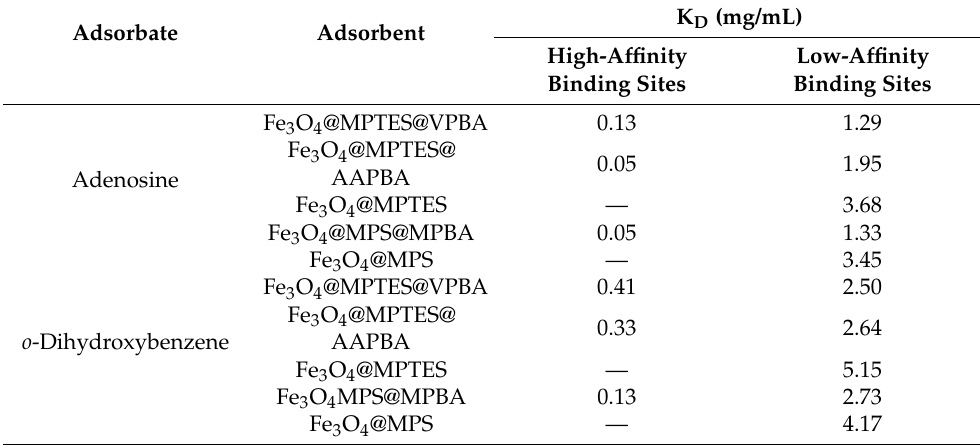
Table 1. K D of different Fe 3 O 4 @PBA for the adsorption of adenosine and o -dihydroxybenzene.